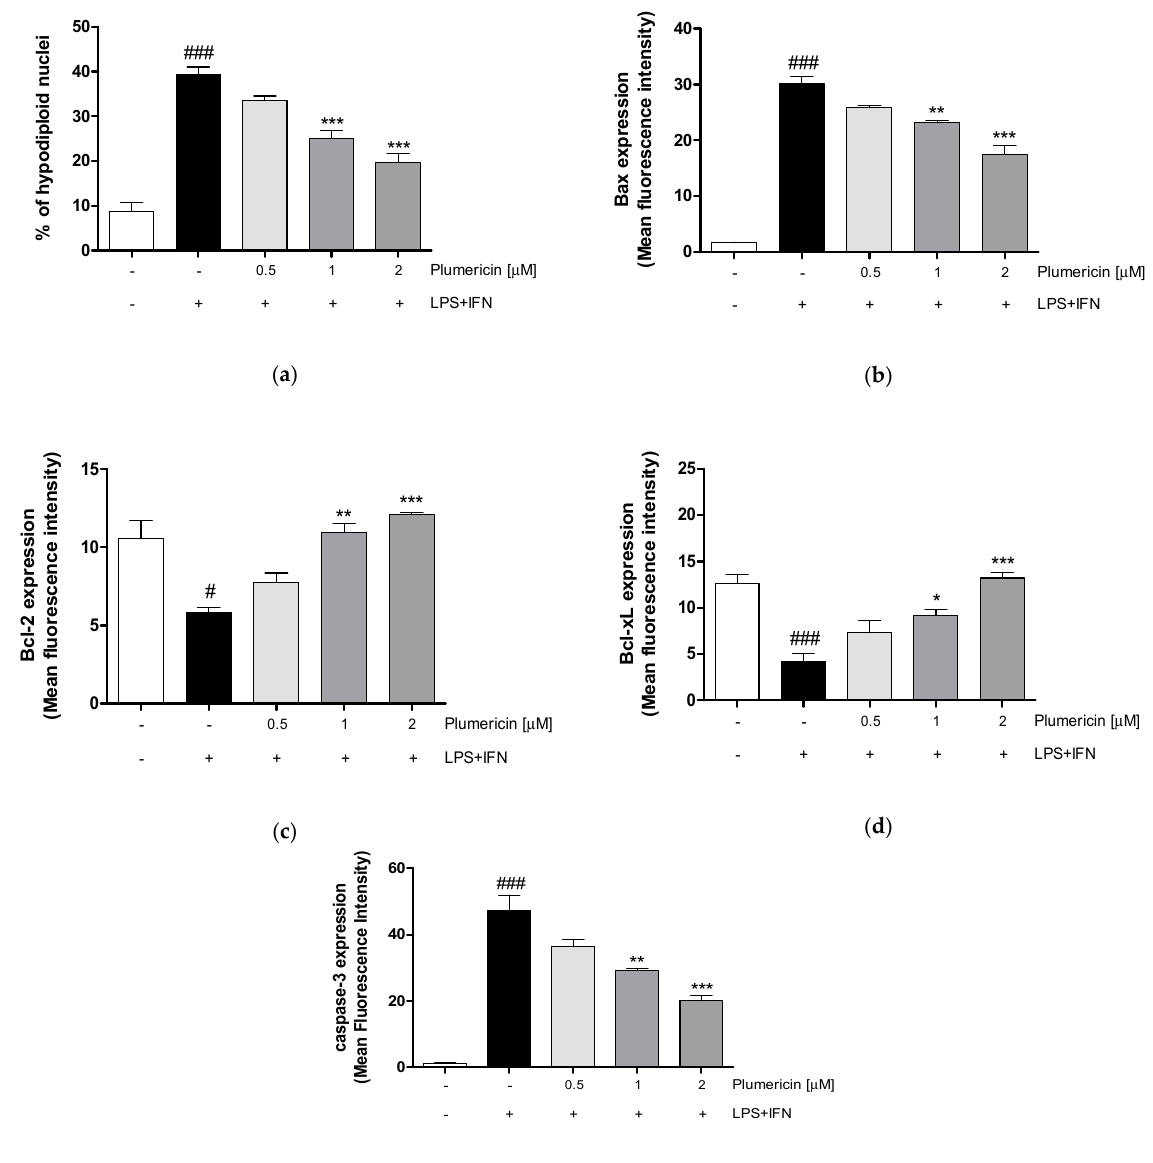
Figure 4. Apoptosis detection by propidium iodide (PI) staining of hypodiploid nuclei ( a ), and effect on Bax ( b ), Bcl-2 ( c ), Bcl-xL ( d ), and Caspase-3 ( e ), after IEC-6 incubation with plumericin. Data are expressed as mean ± S.E.M. of % of hypodiploid nuclei or as mean of fluorescence intensity. ### and # denote, respectively, p < 0.001 and p < 0.05 vs. untreated cells; ***, **, and * denote, respectively, p < 0.001, p < 0.01, and p < 0.05 vs. LPS + IFN.